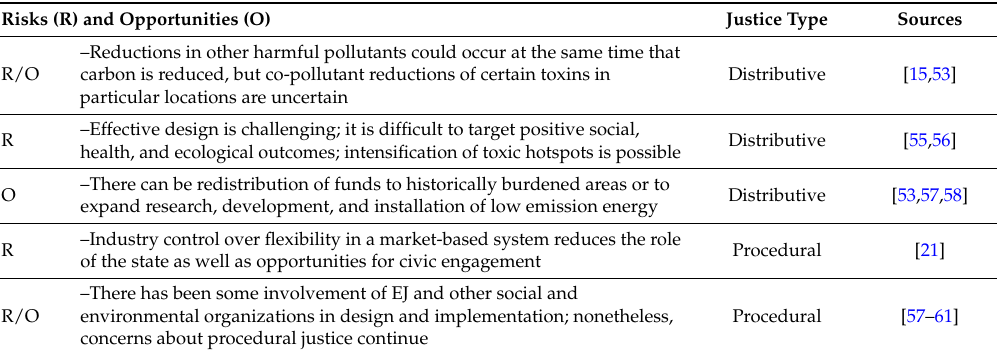
Table 4. Equity and justice potential from